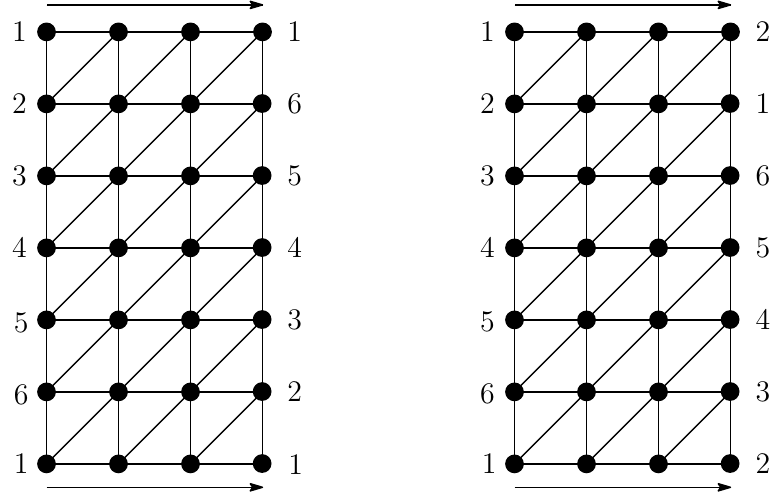
Figure 2: The graphs H (cid:3) with the same